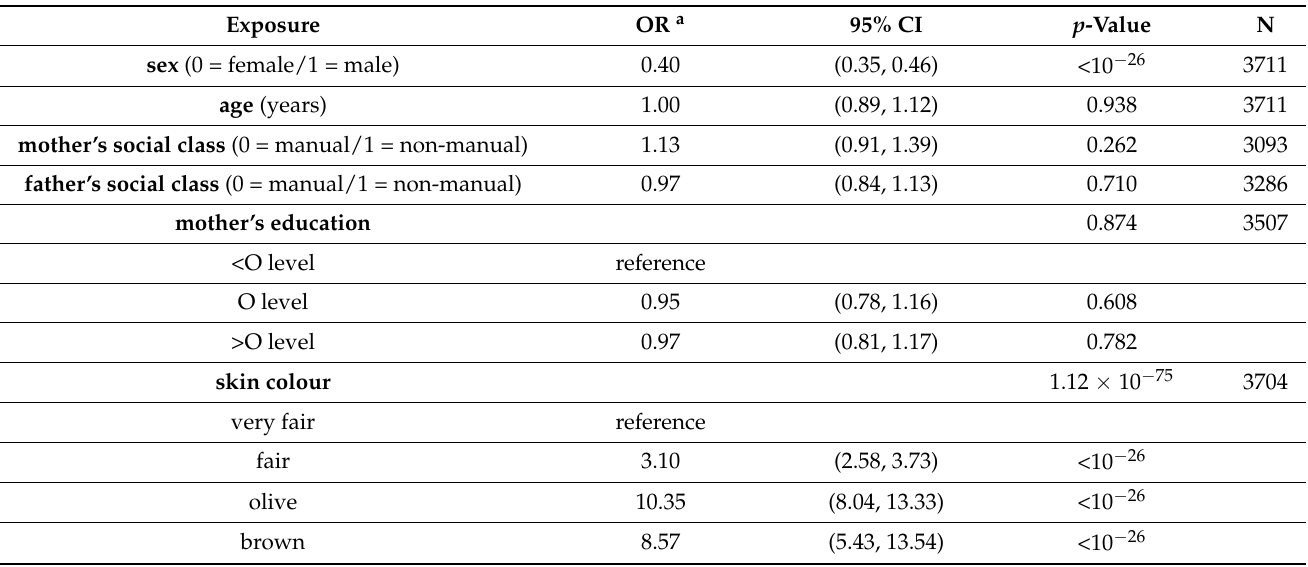
Table 2. Association of socio-demographic, pigmentation-related, and sun exposure factors with ‘liking to tan’ in ALSPAC young people